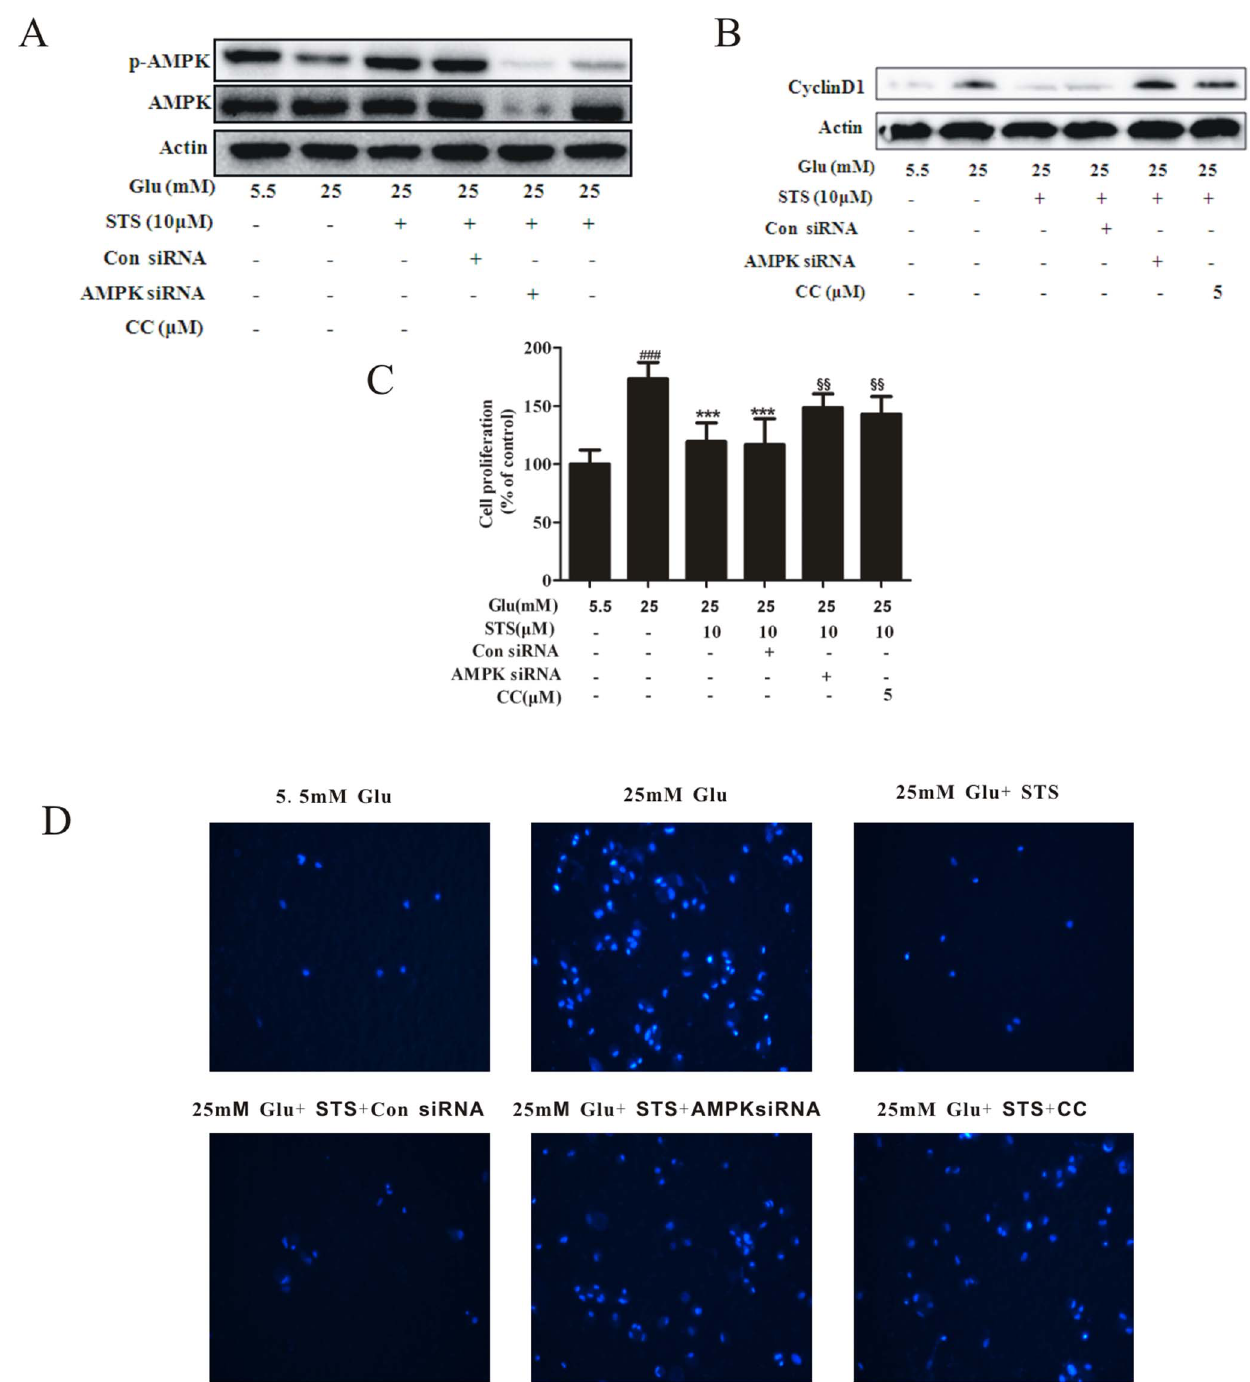
Figure 6. STS inhibits VSMC proliferation and migration through AMPK activation. VSMCs were transfected with AMPK siRNA for 24 h, and co-treated with compound C (CC, 5 m M) or AMPK siRNA or con siRNA with STS (10 m M), and (A and B) stimulated with HG for 24 h, protein expression of p-AMPK and cyclin D1 were determined with Western blot analysis, results are representative of three independent experiments; (C) after stimulation with HG for 48 h, cell proliferation was determined with the MTT assay, n=6, Values are presented as means 6 SD, ### p , 0.001 vs control. *** p , 0.001 vs 25 mM glucose group. $$ p , 0.01 vs HG + STS group; (D) stimulated with HG for 48 h. Migration assays were performed, as described in the Materials and methods section. Results are representative of three independent